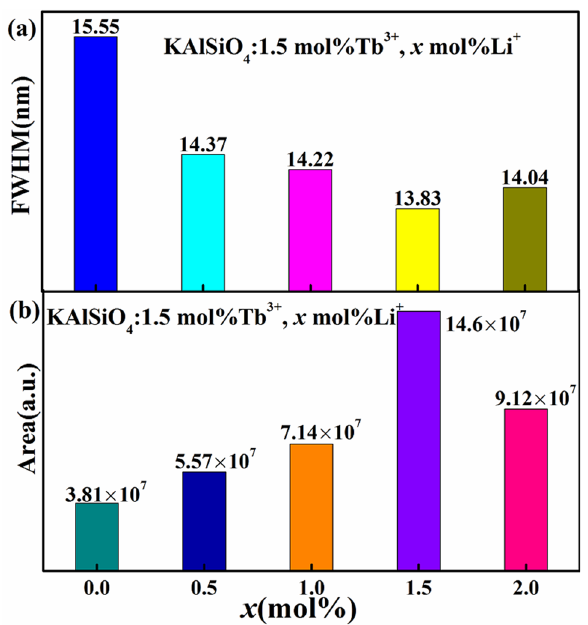
Figure 8. ( a ) Relationship between x and FWHM at 550 nm for KAlSiO 4 : 1.5 mol% Tb 3+ , x mol% Li + sample; ( b ) relationship between x and the integrated peak area at 550 nm for KAlSiO 4 : 1.5 mol% Tb 3+ , x mol% Li + sample.